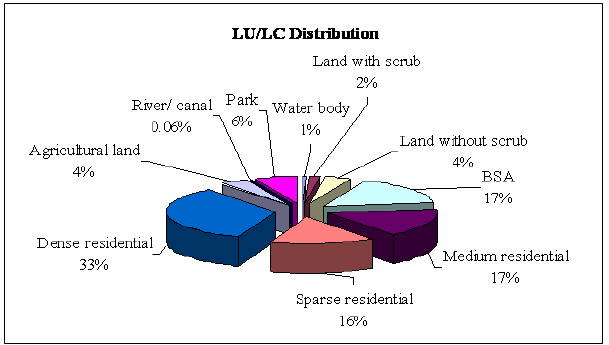
Figure 4: Land use / land cover distribution in the study area Groundwater Quality